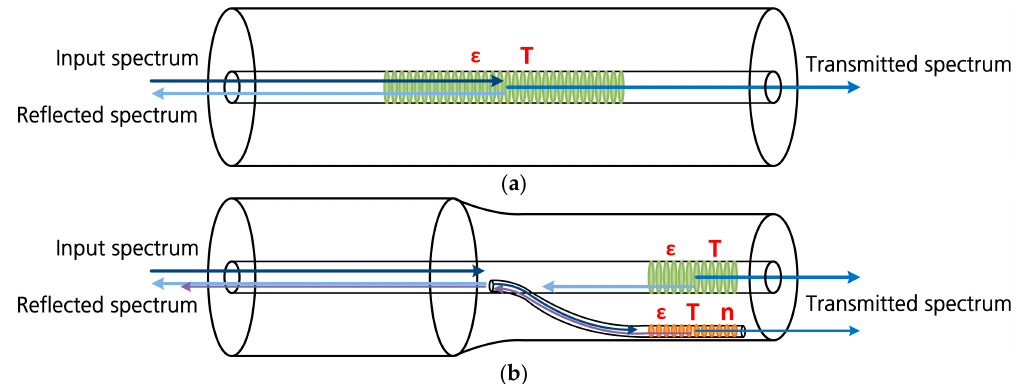
Figure 1. Schematic representation of the light wave spectrum reflection at Bragg gratings inside a glass fiber: ( a ) In the common case, the sensor grating (green colored) is inscribed directly into the waveguide core, so that a part of the light spectrum remaining in the core is reflected in the same way as on an optical mirror; ( b ) by additionally processing a peripheral surface optical waveguide, a portion of the core light can be diverted and guided to the fiber edge region, where it is reflected in the same way on the Bragg grating integrated there. By gently etching, the sensitivity for refractive index variations of the surface cladding waveguide sensor (orange colored) can be increased. With the integration of such a photonic sensor into a lithium ion battery cell, the expansion of the electrodes and temperature variations at the reaction sites can be detected with the Bragg grating located precisely in the central fiber core and simultaneously, mass composition changes in the cell interior can be measured by the second Bragg grating in the fiber edge region, since the local refractive index is directly affected by evanescent fields. The latter parameter information is especially important if changes in the conductive salt concentrations occur due to degradation processes, for example when electrolyte boundary layers increase. This results in the passivation of